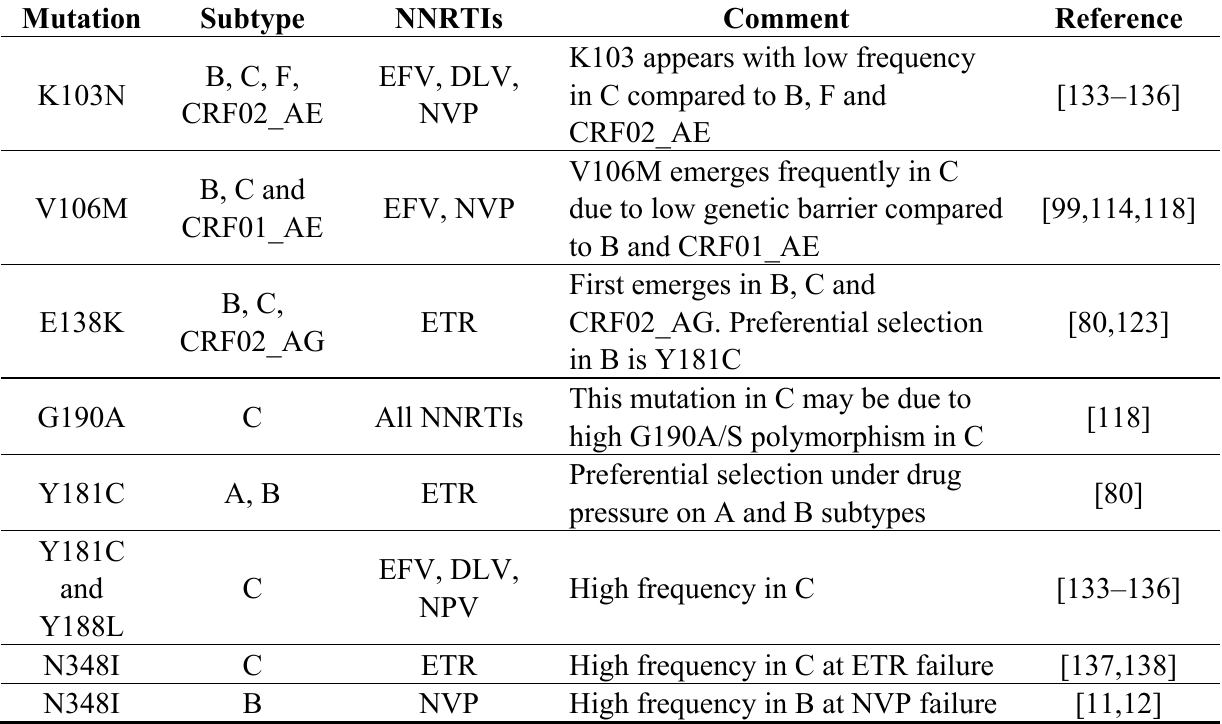
Table 1. NNRTI-resistance mutations in response to NNRTI treatment among different HIV subtypes (modified from Santoro and Perno,